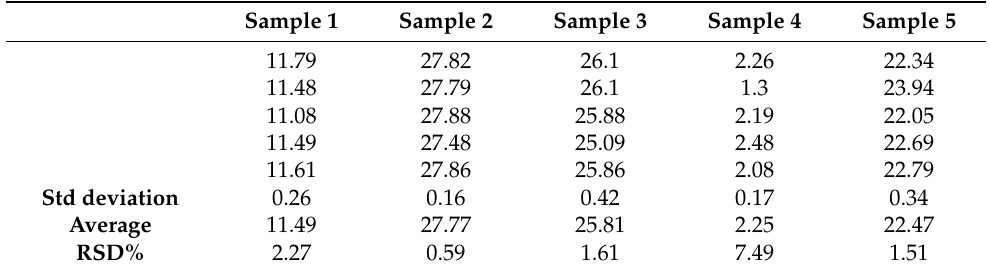
Table 1. IR method reproducibility with different bee pollen samples containing different amounts of